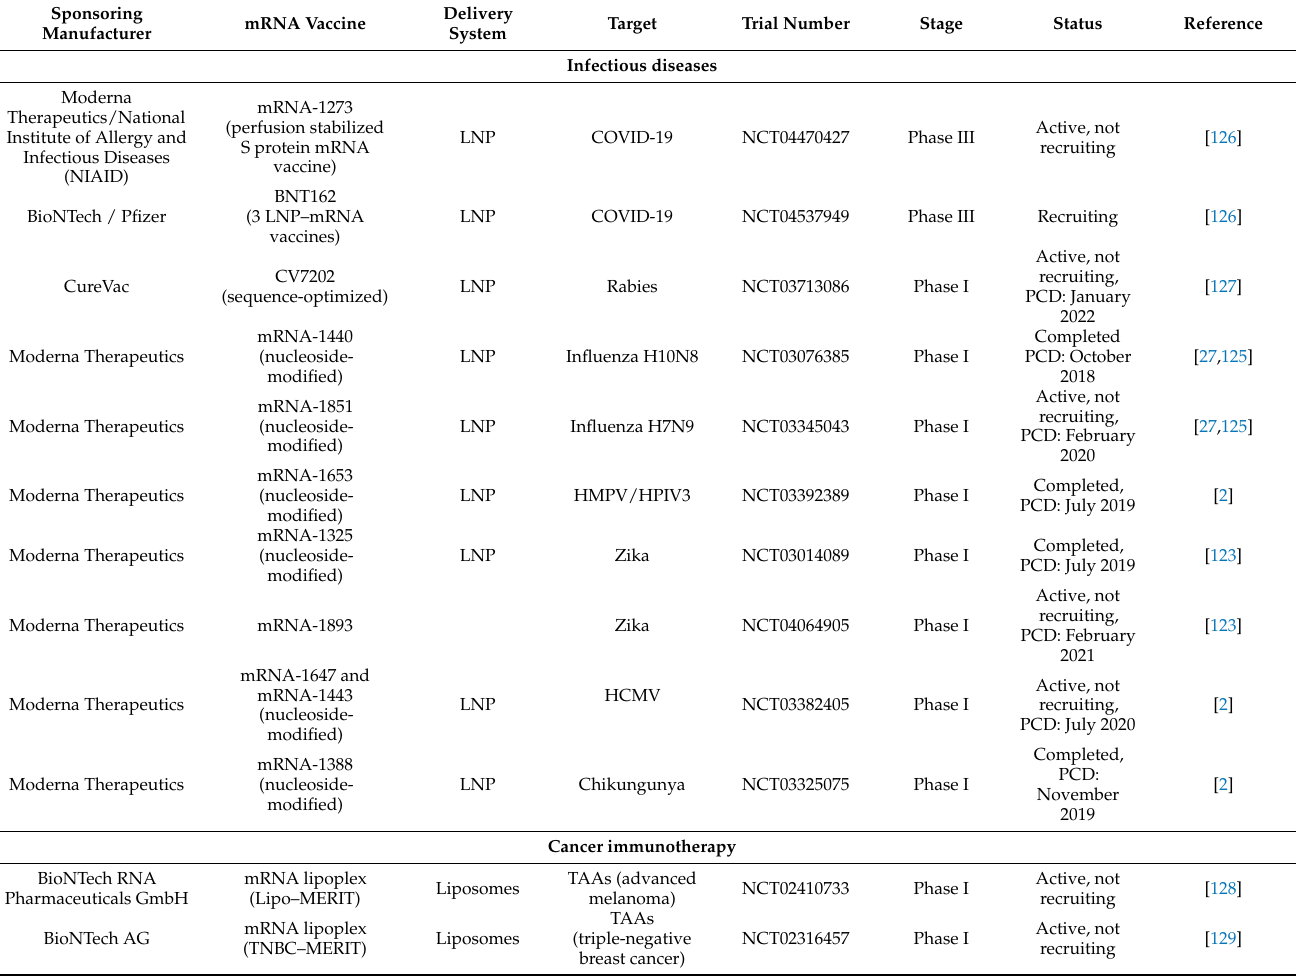
Table 2. mRNA vaccines that entered clinical studies against infectious diseases and